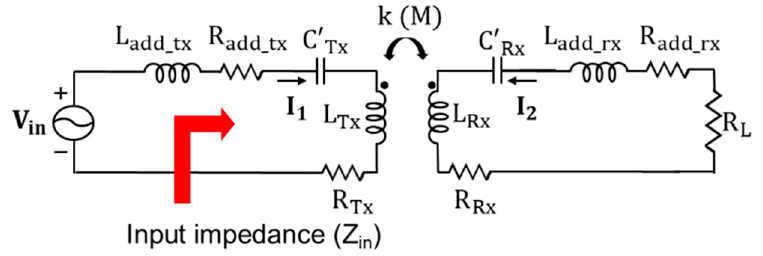
Figure 7. A WPT system with series inductors on the Tx and Rx sides.